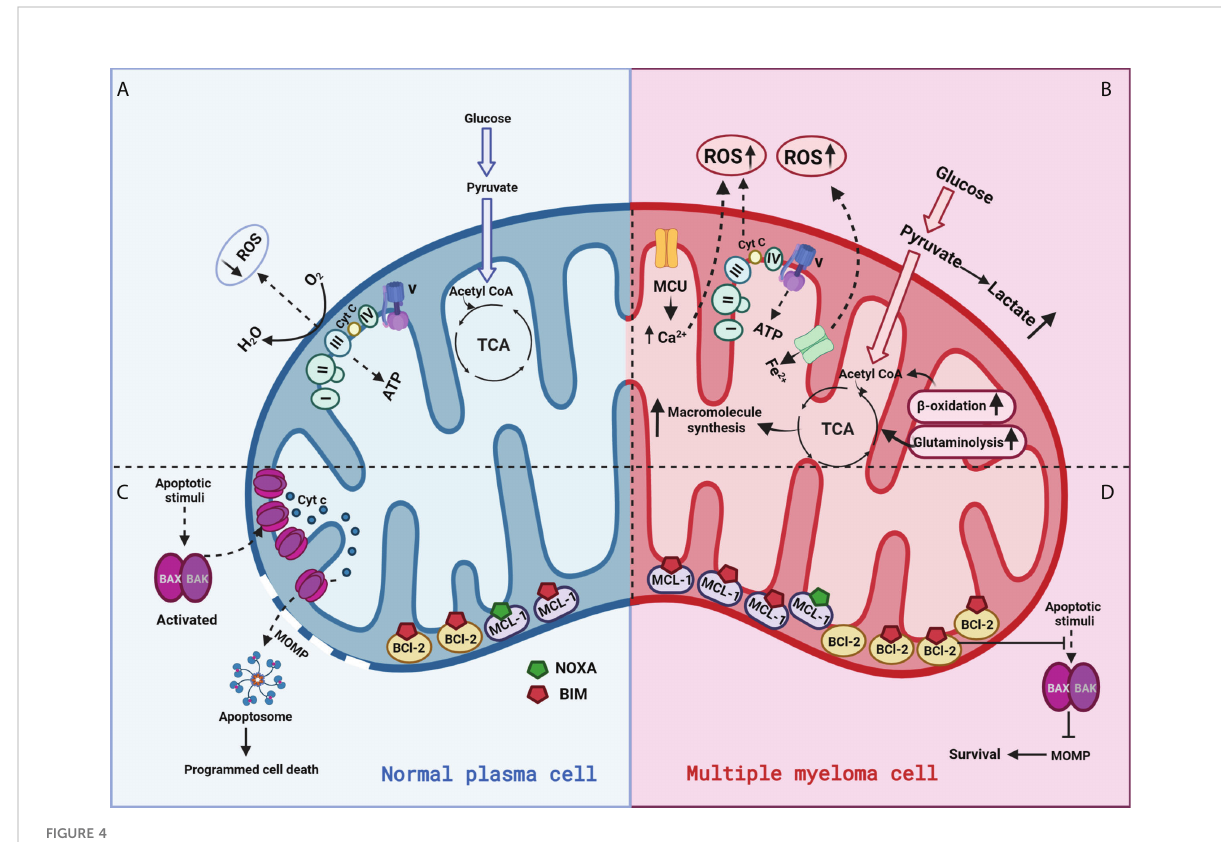
FIGURE 4 Mitochondrial functions in a normal plasma vs multiple myeloma cell: (A) In normal plasma cells, glucose is primarily metabolized through glycolysis into pyruvate and acetyl-CoA. Acetyl-CoA enters the mitochondrial TCA cycle to produce a series of intermediates and reducing equivalents that are utilized by the ETC to generate ATP through OXPHOS; (B) Cancer cells generate energy preferentially by glycolysis even in the presence of oxygen, a phenomenon known as the “ Warburg effect. ” This metabolic switch towards “ aerobic glycolysis ” increases glucose uptake mediated via glucose transporter (GLUT) upregulation and oxidation of pyruvate to lactate. (C) Normal cells appropriately respond to stress by activating apoptosis; (D) Cancer cells overexpress anti-apoptotic proteins (BCL-2) to counteract pro-apoptotic BAX/BAK activation, allowing for the evasion of programmed cell